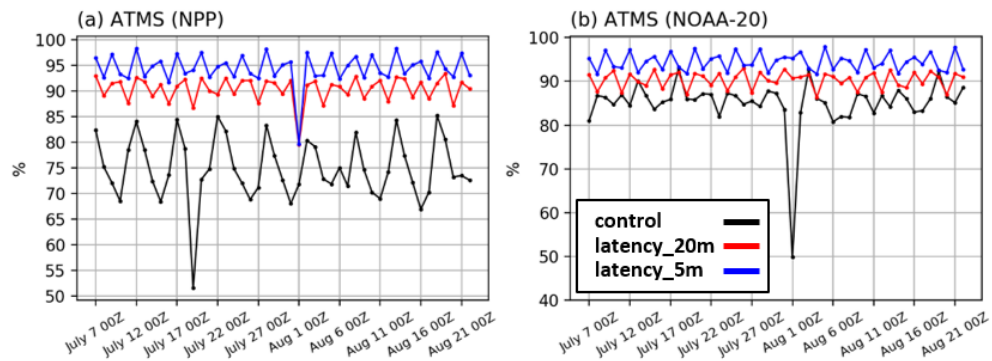
Figure 4. Time series of assimilated data ratio of Advanced Technology Microwave Sounder (ATMS) MW sounders onboard ( a) Suomi National Polar-orbiting Partnership (S-NPP) and ( b ) National Oceanic and Atmospheric Administration (NOAA–20) satellites for the period from 7 July to 22 August 2018. Black, red, and blue lines indicate the control, latency_20m, and latency_5m runs, respectively. Similar to the results of the IR sounders, a 20-min latency (5-min latency) also enhances the data usage ratio of the ATMS MW sounders up to about 90% (95%) (Figure 4). For the operational